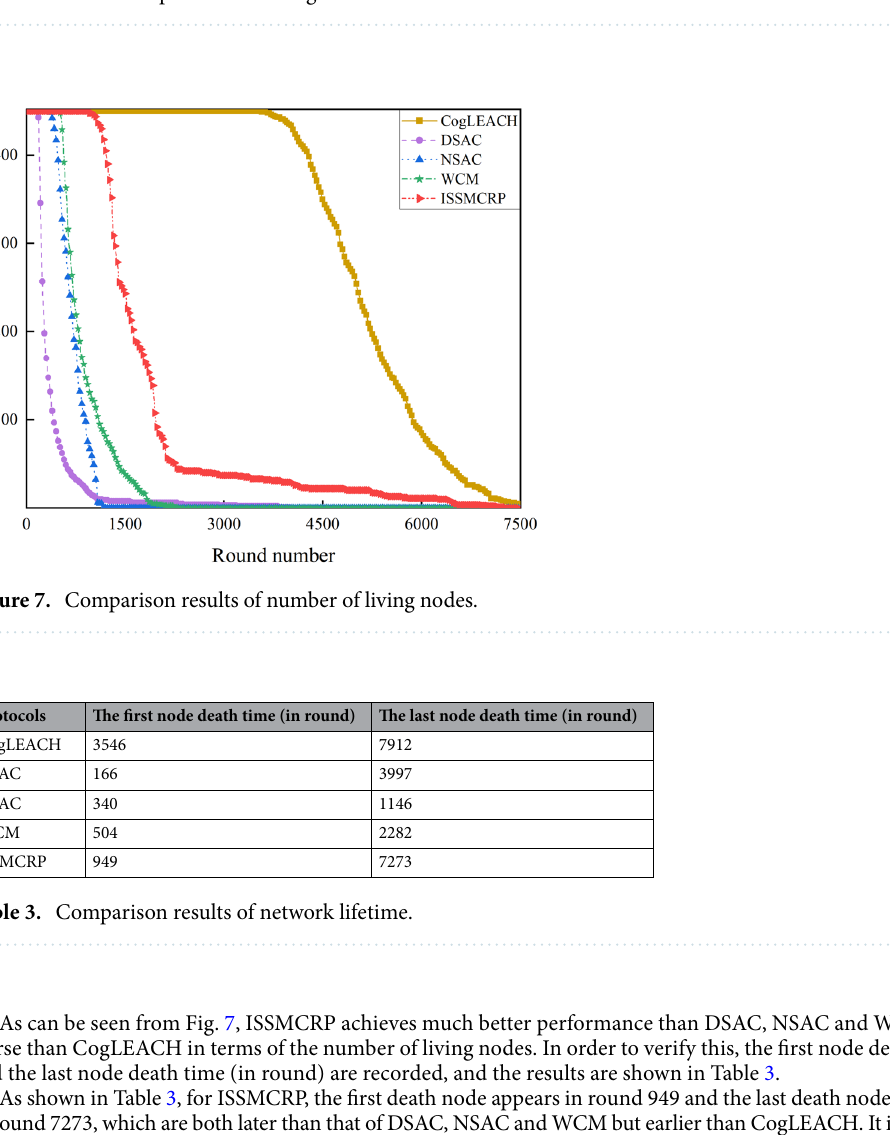
Table 2. Simulation parameter settings.